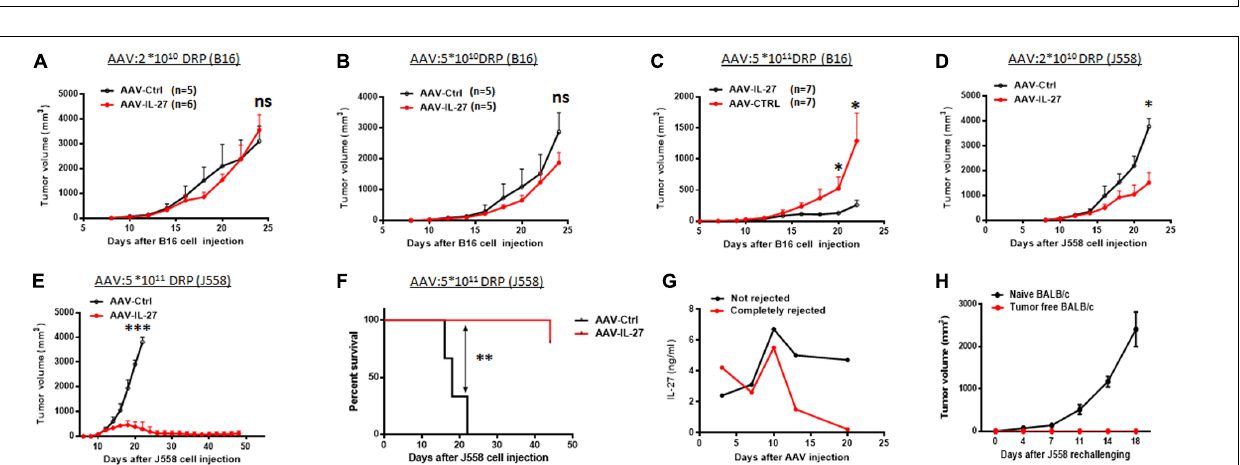
FIGURE 1 | AAV can efficiently infect tumor cells in vitro and in vivo . (A,B) B16.F10 melanoma cells were incubated with AAV-GFP at a concentration of 5 × 10 9 DRP (DNase resistant particles) for 48 h and GFP-positive melanoma cells were analyzed and quantified by flow cytometry. (C,D) B16.F10 melanoma cells were infected with AAV-IL-27 at various concentrations, and the expression of IL-27 mRNA (C) in melanoma cells and IL-27 protein (D) in the cell culture supernatants were quantified by qPCR or ELISA. (E,F) AAV-IL-27 was directly injected into established B16 melanoma tumors in C57BL/6 mice and the blood samples were collected at different time points. Mice were sacrificed 2 weeks after AAV injection and the concentrations of IL-27 in tumor tissues (E) and blood (F) were quantified by ELISA. (G,H) J558 plasmacytoma cells were infected with AAV-IL-27 at various concentrations, and the expression of IL-27 mRNA (G) in J558 cells and IL-27 protein (H) in the cell culture supernatants were quantified by qPCR or ELISA. (I–J) AAV-IL-27 was directly injected into established J558 tumors in BALB/c mice and the blood samples were collected at different time points. Mice were sacrificed 3 weeks after AAV injection and the concentrations of IL-27 in tumor tissues (I) and blood (J) were quantified by ELISA. Data are expressed as Mean ± SD of 3-5 samples in each group/per time point. * P < 0.05, ** P < 0.01, *** P < 0.001 by one-way ANOVA or student’s t test.